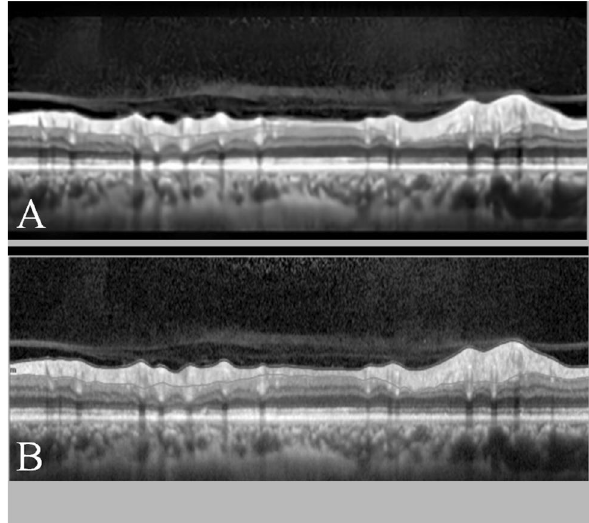
Figure 4. Image processing before ( A ) and after ( B ) denoising.